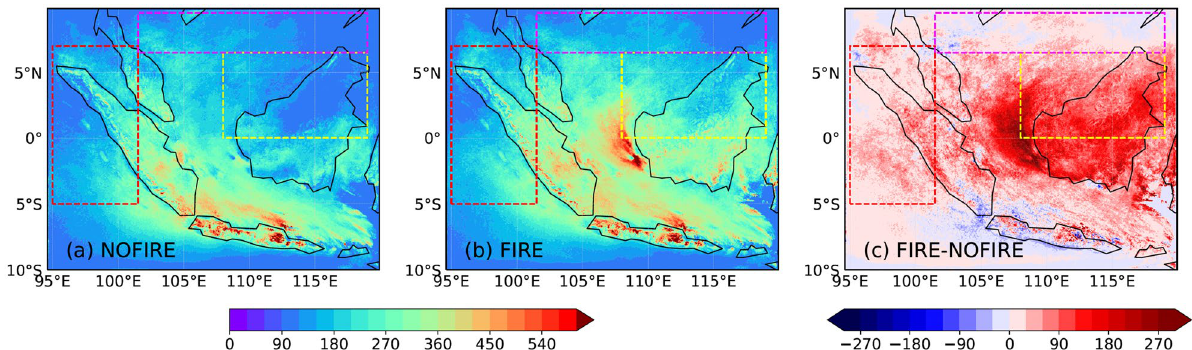
Figure 5. Maps of n zmax (cm − 3 ) for ( a ) WRF-NOFIRE, ( b ) WRF-FIRE, and ( c ) their difference (FIRE- NOFIRE) over the nested